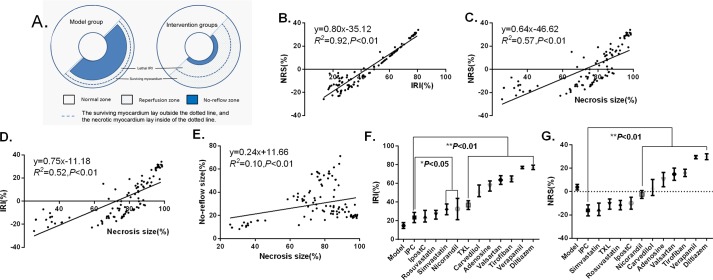
Comparison of lethal IRI under all interventions.
A: Illustration for lethal IRI zone. The no-reflow zone was unstained using thioflavin S, and the necrotic zone was unstained using TTC. The surviving myocardium lies outside the dotted line, and the necrotic myocardium lies inside of the dotted line. B: The positive correlation between NRS value and IRI value (R
2 = 0.92, P<0.01) indicates NRS is a valuable surrogate marker for lethal IRI severity. C-D: Necrosis size is positively correlated with NRS (R
2 = 0.57, P<0.01) or IRI value (R
2 = 0.52, P<0.01), underlining the linear relationship between IRI and necrosis size. E: Necrosis size has weak linear relationship with no-reflow size (R
2 = 0.10, P<0.01). F-G: Observational values of NRS and IRI were expressed as the mean±SE; the error bars were the standard deviations. The significance of differences between groups was analyzed using the one way ANOVA, *P<0.05, **P< 0.01 vs IPC group. Abbreviations: NRS = necrosis reduction space; IRI = ischemia/reperfusion injury.